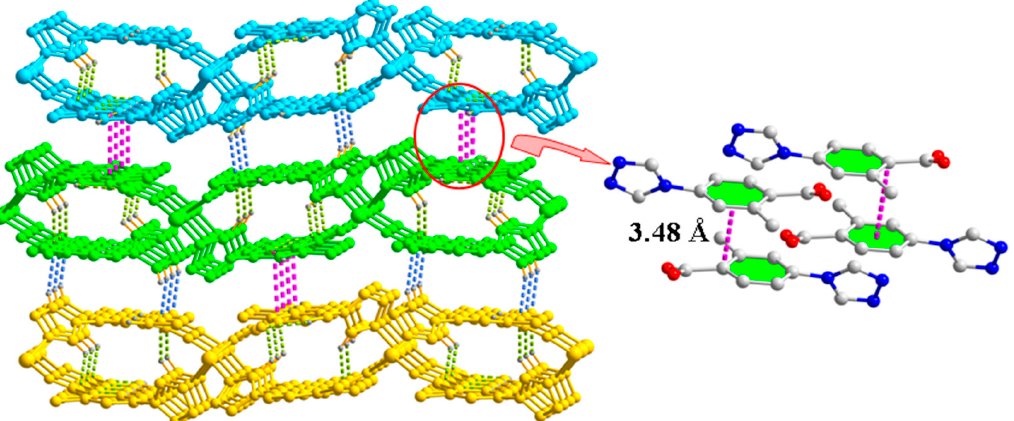
Figure 4. 3D coordination polymer of 1 packed by intramolecular and intermolecular hydrogen bonds and π−π interactions with a centroid − centroid distance of 3.48 Å.